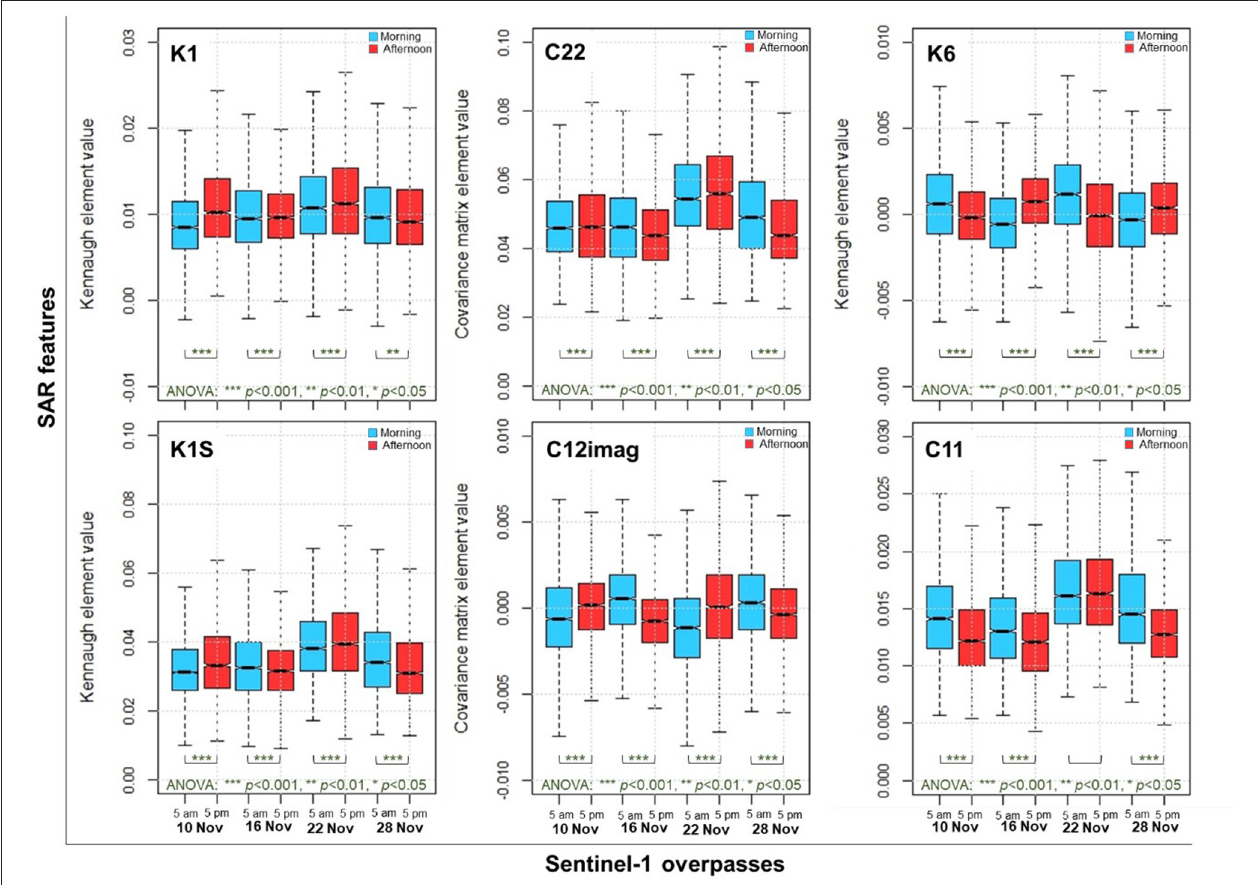
FIGURE 7 | Box plots for the topmost ranking SAR parameters in the RF model θ NovSAR for the Sentinel-1 overpasses in the morning (blue color) and in the afternoon (red color). Significant variances of the distributions of parameter values are provided for each day. The asterisks indicate the level of significance (*** p < 0.001, ** p < 0.01, * p < 0.05). Parameters are displayed according to their order of importance ( Figure 6A ) from upper left to lower